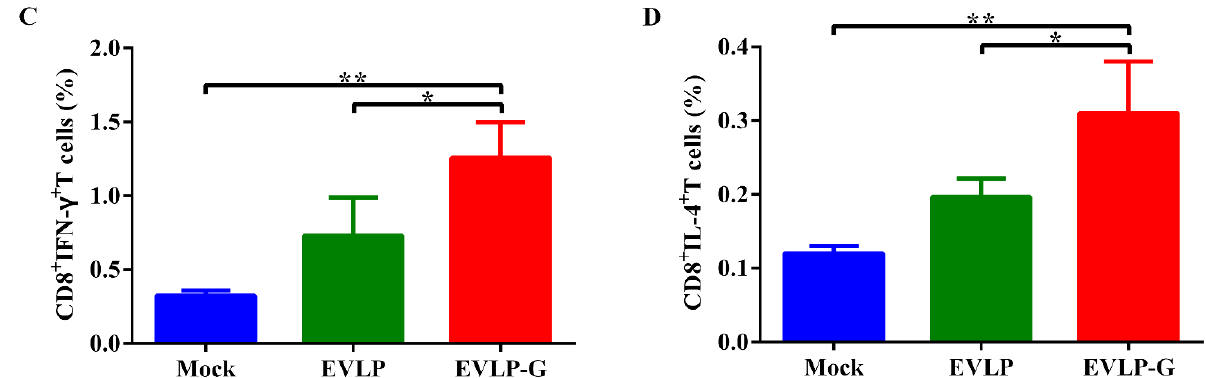
Figure 4. ICS assays for antigen-specific CD4 + and CD8 + T cells secreting IFN-γ or IL-4. The spleen from 3 mice of each group were isolated 2 weeks after the last